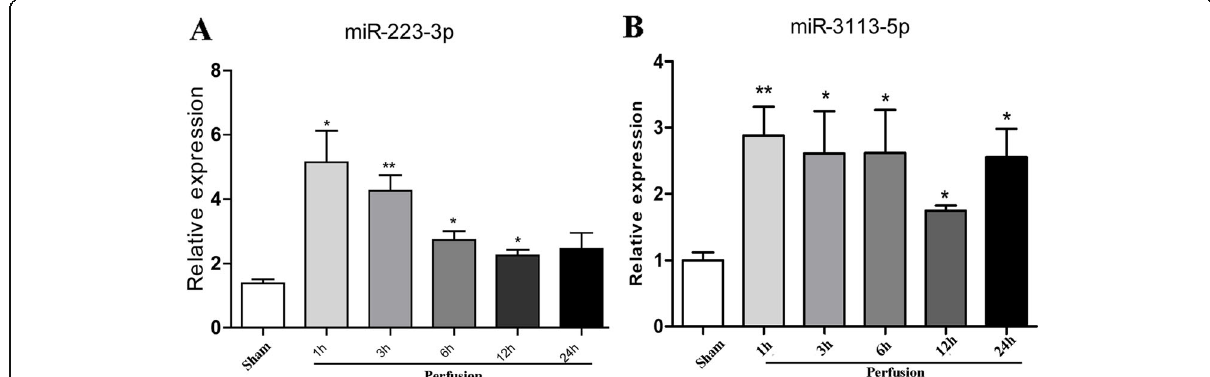
Fig. 5 Circulating microRNA 3113-5p stably increased in the perfusion hours. a RT-qPCR analysis of circulating microRNA 223-3p in serum samples. b RT-qPCR analysis of microRNA 3113-5p in serum samples. *, p < 0.05; **, p < 0.01 vs. Sham